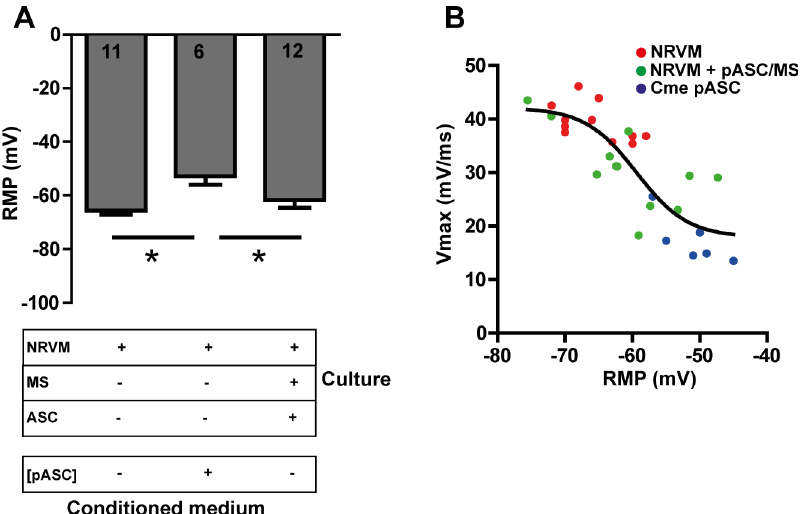
Fig 7. The relationship between RMP and Vmax. A: The effect of conditioned medium and pASC loaded microspheres on the RMP. B: The relationshipbetweenRMP and Vmax in the different cultures * indicates p (cid:20) 0.05. Number of cells analyzedis indicatedin the bar-graphs. Abbreviations; Cme: conditioned medium, MS: microspheres, NRVM: neonatalrat ventricular myocytes, pASC: porcine adiposetissue-derived stromal cells, and RMP: resting